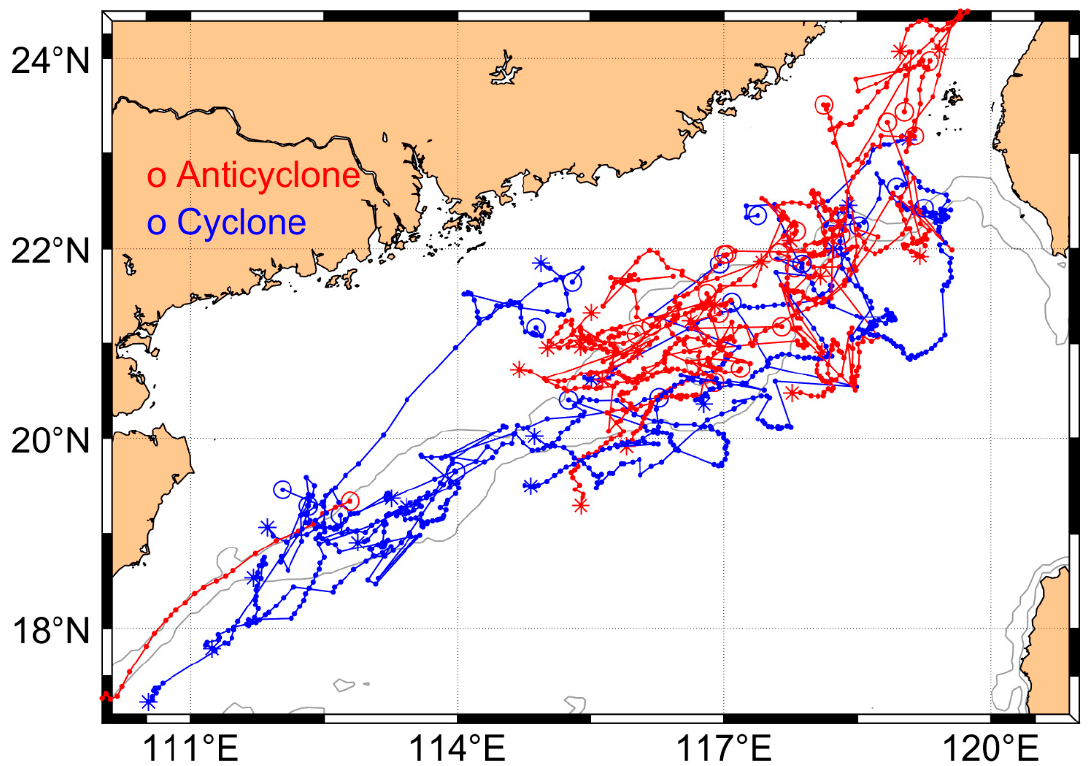
Figure 10. The pathways of the shelf-internal-generation mesoscale eddies. The red curves with points are anticyclonic eddies. The blue curves with points are cyclonic eddies. The circles indicate generation and the asterisks indicate corruption.